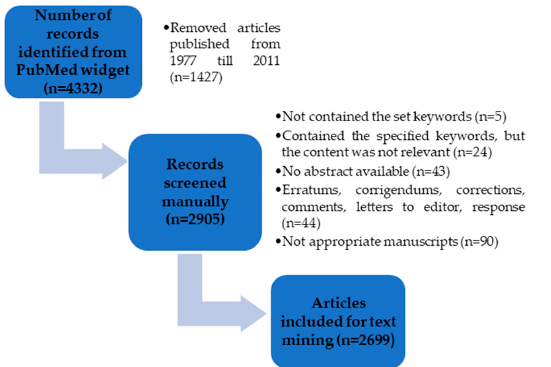
Figure 2. A summary of the papers considered at each stage of the review process and total number of extracted papers.